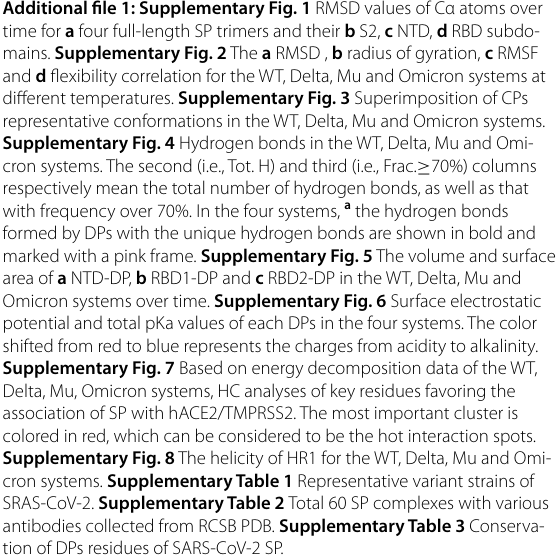
Supplementary Fig. 8 The helicity of HR1 for the WT, Delta, Mu and Omi- cron systems. Supplementary Table 1 Representative variant strains of SRAS-CoV-2. Supplementary Table 2 Total 60 SP complexes with various antibodies collected from RCSB PDB. Supplementary Table 3 Conserva- tion of DPs residues of SARS-CoV-2